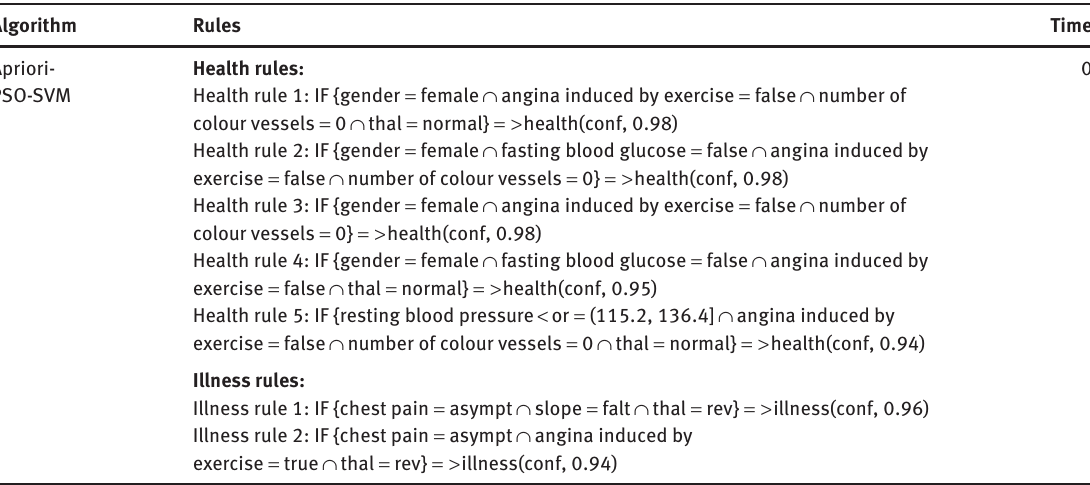
Table 1: Health and Illness Rules Extracted Using the Apriori Algorithm.